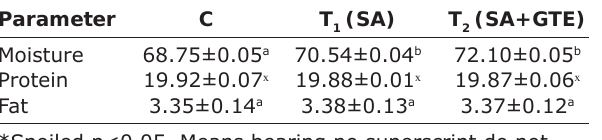
Table-5: Proximate composition (mean±SE) of chicken meat nuggets as influenced by different coatings. Parameter C